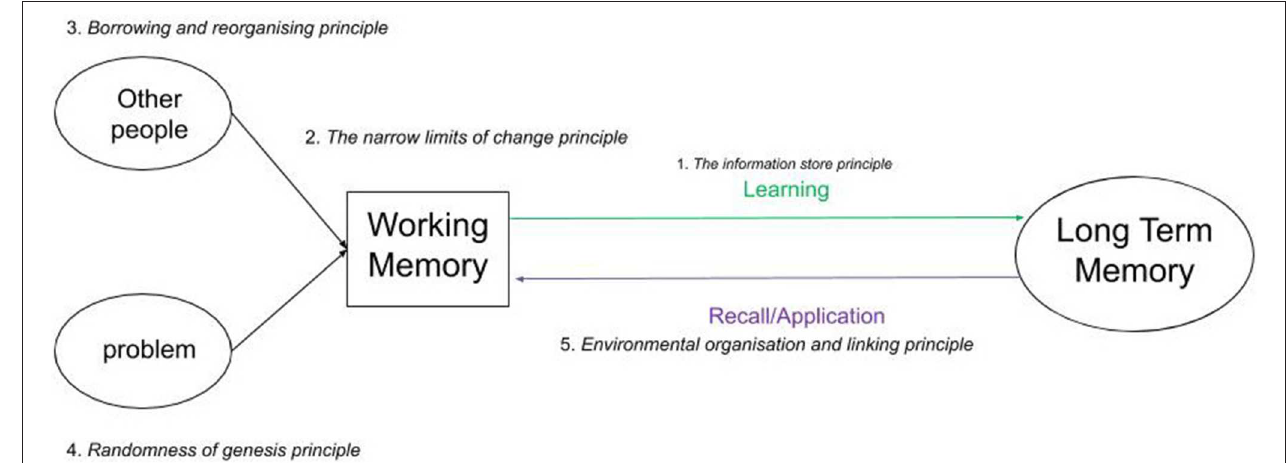
FIGURE 1 | Evolutionary principles of the cognitive